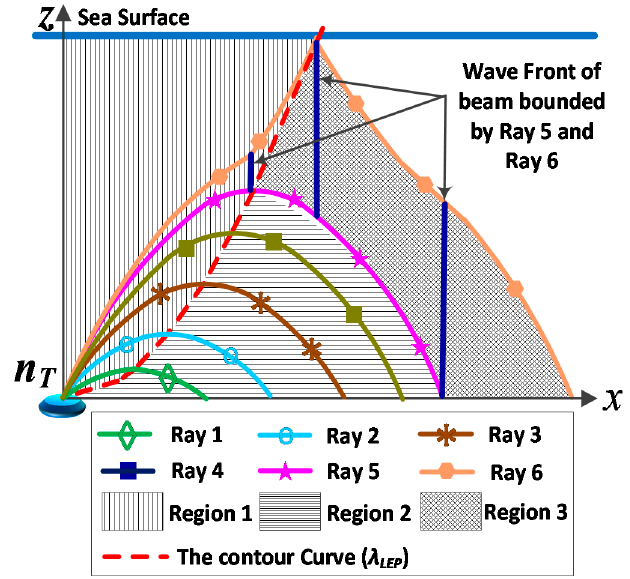
Figure 10. Demonstration of different regions generated in underwater environment where SSP of the water column dictates the boundary of each one.